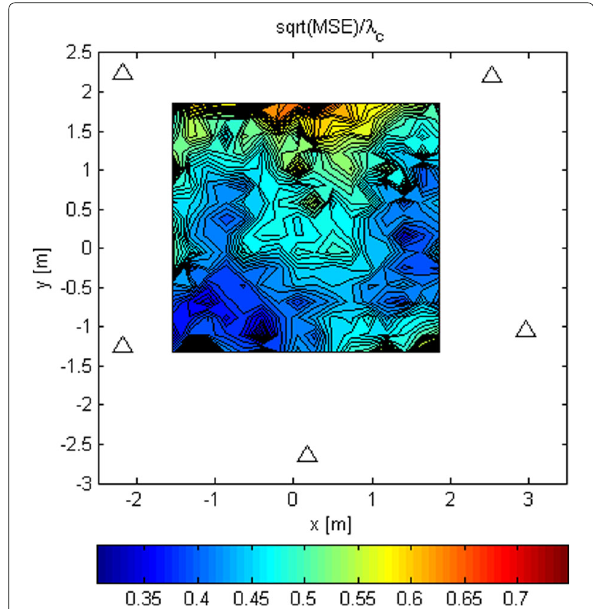
Fig. 14 RMSE/ λ c of stage 2 for G 1 and N = 1024 estimate of this stage is far away from the reference antenna, another antenna can be adopted as the refer- ence and the process is repeated. Stage 3 could benefit from choosing a better reference antenna even more. The RMSE of stage 1 varies between 6 and 12 λ c in the given area. These values determine how narrow the search grid in the next stage can be for a given Tx position, because